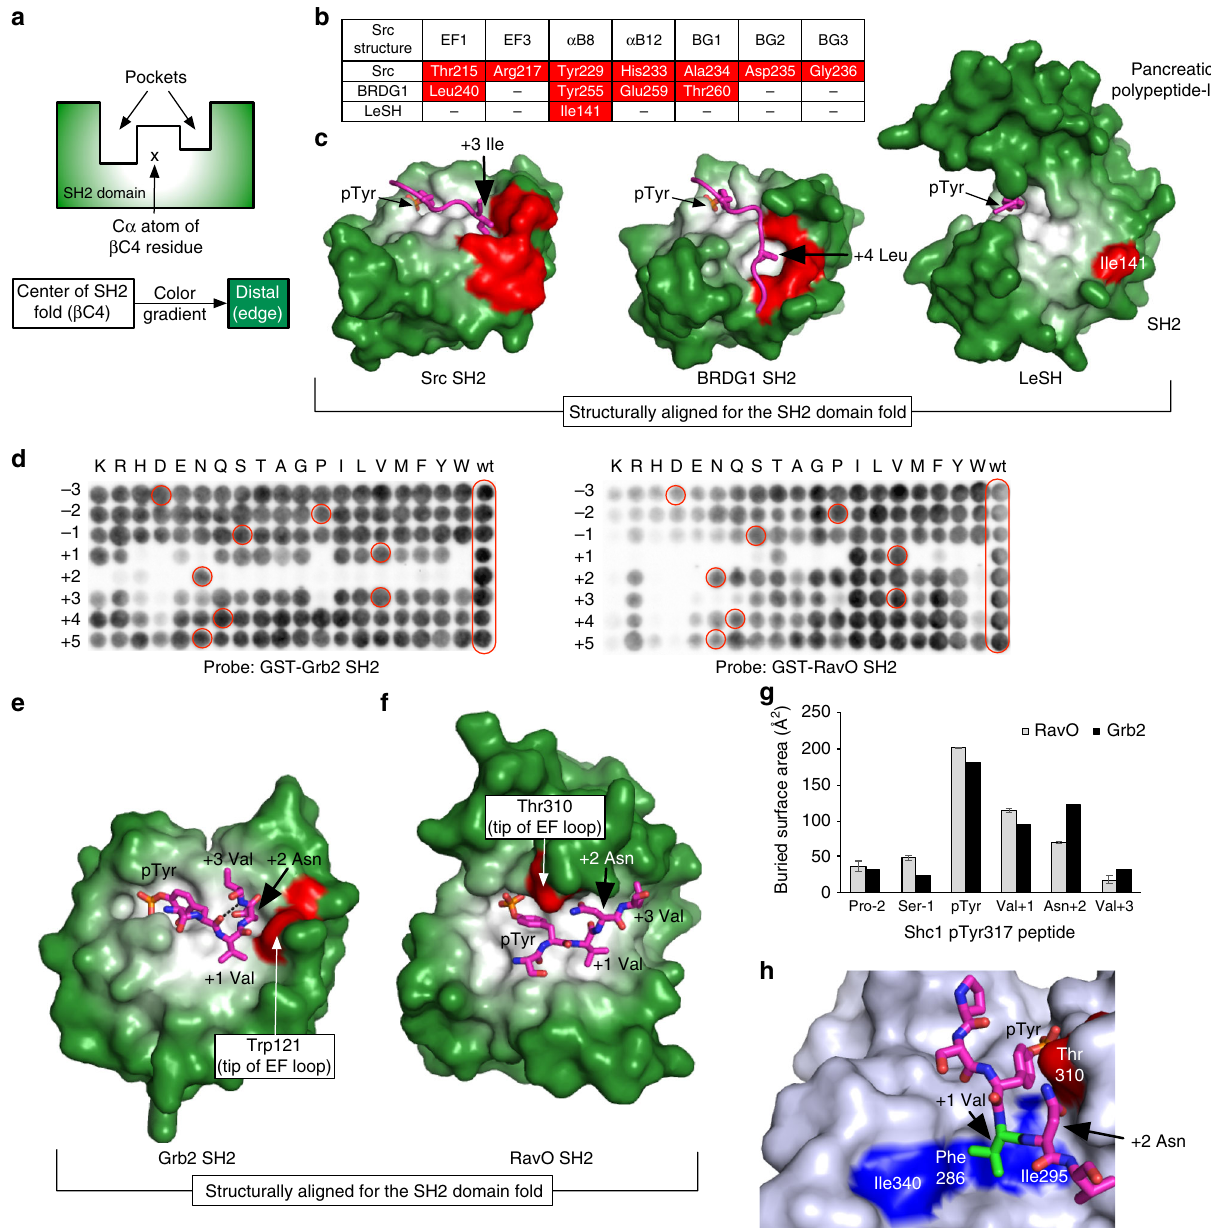
Fig. 6 The Legionella SH2 domains lack a speci fi city pocket. a A color gradient depicting the distance of the ligand-binding pockets on a typical eukaryotic SH2 domain to the center of the globular SH2 domain fold. The C α atom of the β C4 residue of an SH2 domain was de fi ned as the origin of the color gradient, from white to dark green, to facilitate visualization of the speci fi city pocket in an SH2 domain. b Residues that contribute to forming the inside lining of either the P + 3 or + 4-binding pocket in SH2 domains. The P + 3 (Ile)-binding pocket in the Src SH2 domain involves the EF1, EF3, BG2, and BG3 residues whereas the P + 4 (Leu)-binding pocket in the BRDG1 SH2 domain is formed by the EF1, α B8, α B12, and BG1 residues. A 3D structural alignment of the two SH2 domains with LeSH was used to identify structurally equivalent residues in the latter. The symbol ( – ) indicates absence of an equivalent residue in the structure. c Comparison of the structure of the LeSH-DnaJ-A1 peptide complex with those of the Src and BRDG1 SH2 domains. The bound peptides are pTyr-Glu-Glu-Ile for the Src SH2 domain, and pTyr-Glu-Asn-Val-Leu for the BRDG1 SH2 domain. Only the side chains of the key residues (Ile + 3 for the Src SH2 ligand and Leu + 4 for the BRDG1 SH2 ligand) are shown in magenta sticks. The pocket-forming residues listed in b are colored red. d A permutation array based on the Shc1 pTyr317 peptide (DPSpYVNVQNL) probed with either the GST-fused Grb2 (left panel) or RavO SH2 domain (right panel). The amino acid at each position between − 3 and + 5 was replaced by one of 19 natural amino acids (except for Cys). The pTyr residue was fi xed. The peptide spots identical to the wild-type (wt) sequence are highlighted in red circles. e , f Comparison of the LeSH and human Grb2 SH2 domains bound to the same peptide (Shc1 pTyr317). The human Grb2 SH2 domain ( e ) is structurally aligned with the L. pneumophila RavO SH2 domain ( f ). The Shc1 peptide Ser-pTyr-Val-Asn-Val is shown in magenta sticks. The residue located at the tip of the EF loop is colored red for each SH2 domain. g The buried surface area (in Å 2 ) calculated for each residue of the Shc1 pTyr317 peptide bound to the SH2 domain of RavO or Grb2. The error bars for the area from the RavO complex indicate deviations between the three copies of SH2-peptide complexes in the asymmetric unit (Supplementary Fig 9e and f). h The hydrophobic patch on the RavO SH2 domain used for accommodating the + 1 position of the ligand